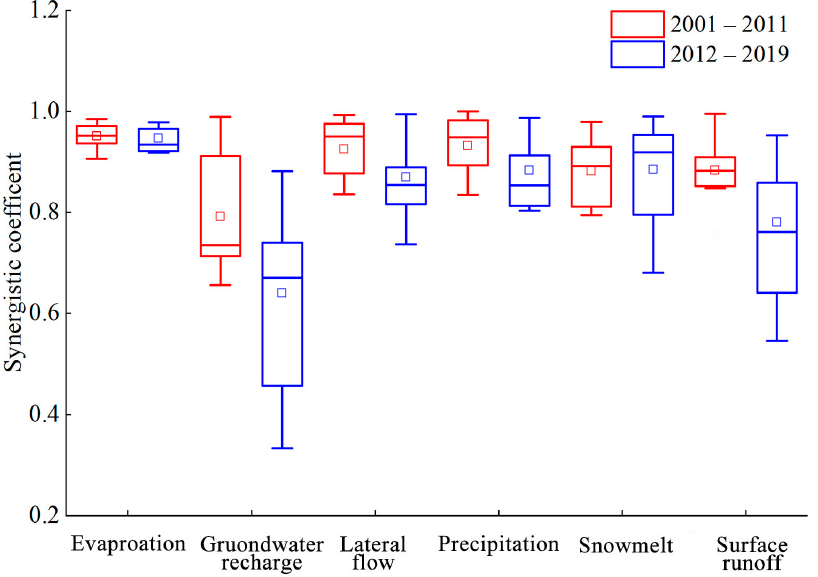
Figure 11. Interannual synergistic relationship between hydrological process factors and EQ.